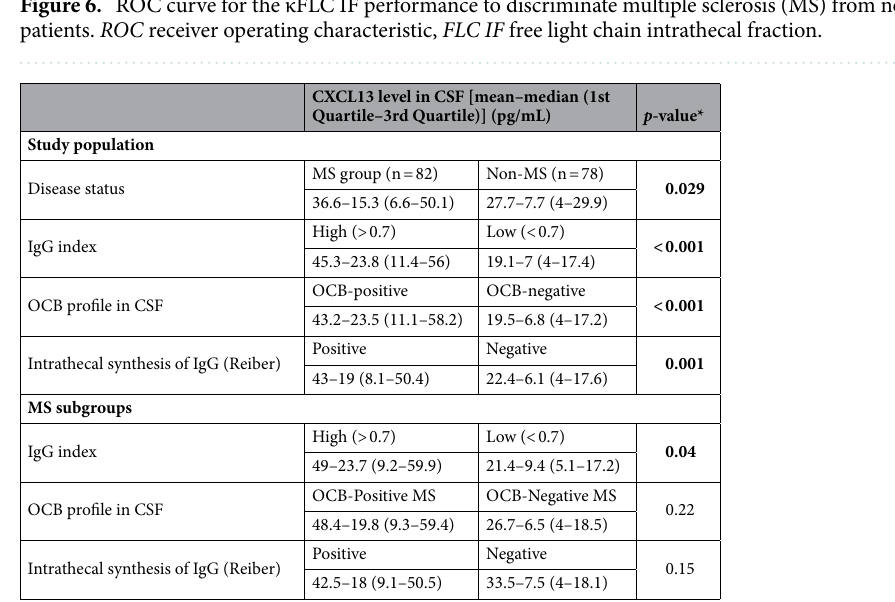
Table 4. Quantitative analysis of CXCL13 level in CSF in the study population. CSF cerebrospinal fluid, MS multiple sclerosis disease, Ig Immunoglobulin, OCB oligoclonal bands. *U test of Mann–Whitney. Significant p values are in